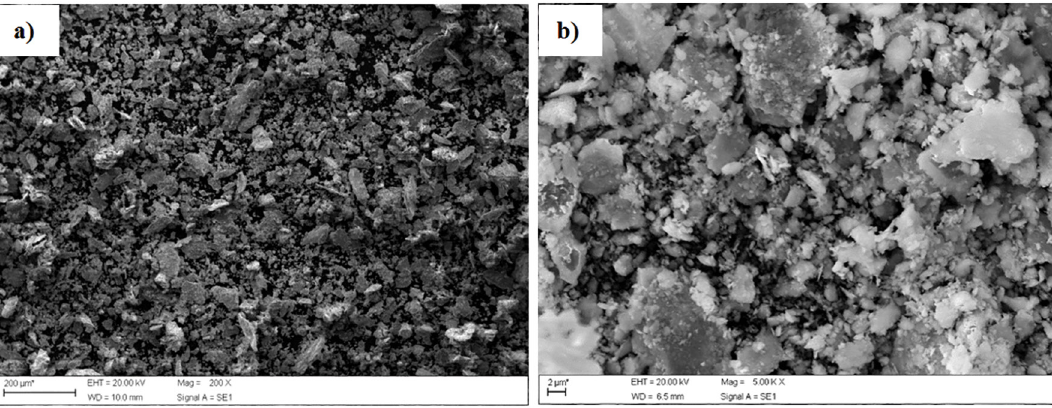
Figure 6. Aluminum bronze powders after 100 hours milling (a); morphology of different submicrometric particles